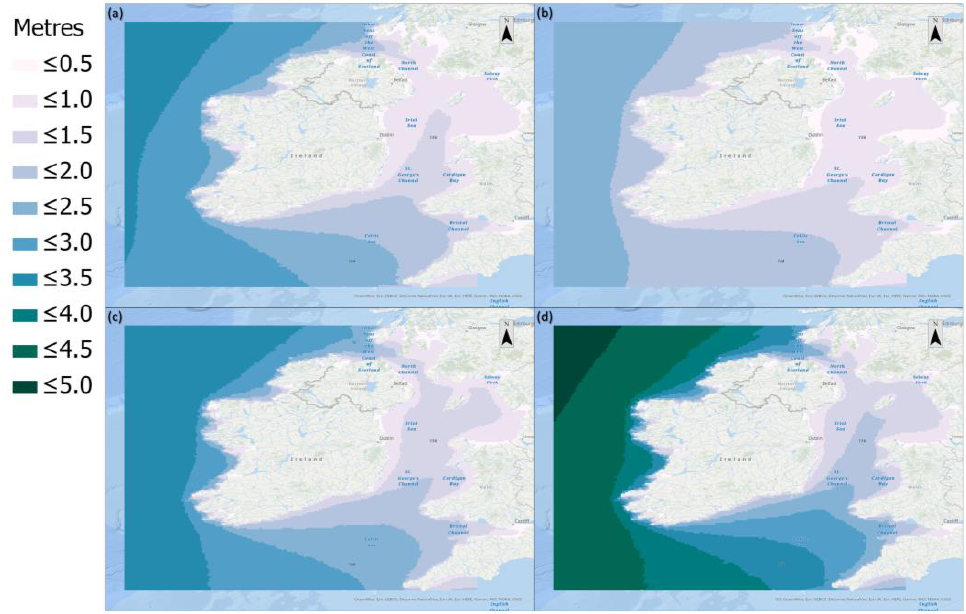
Figure A1. The seasonal mean significant wave height (H s ) in metres for ( a ) spring, ( b ) summer, ( c ) autumn and ( d ) winter.